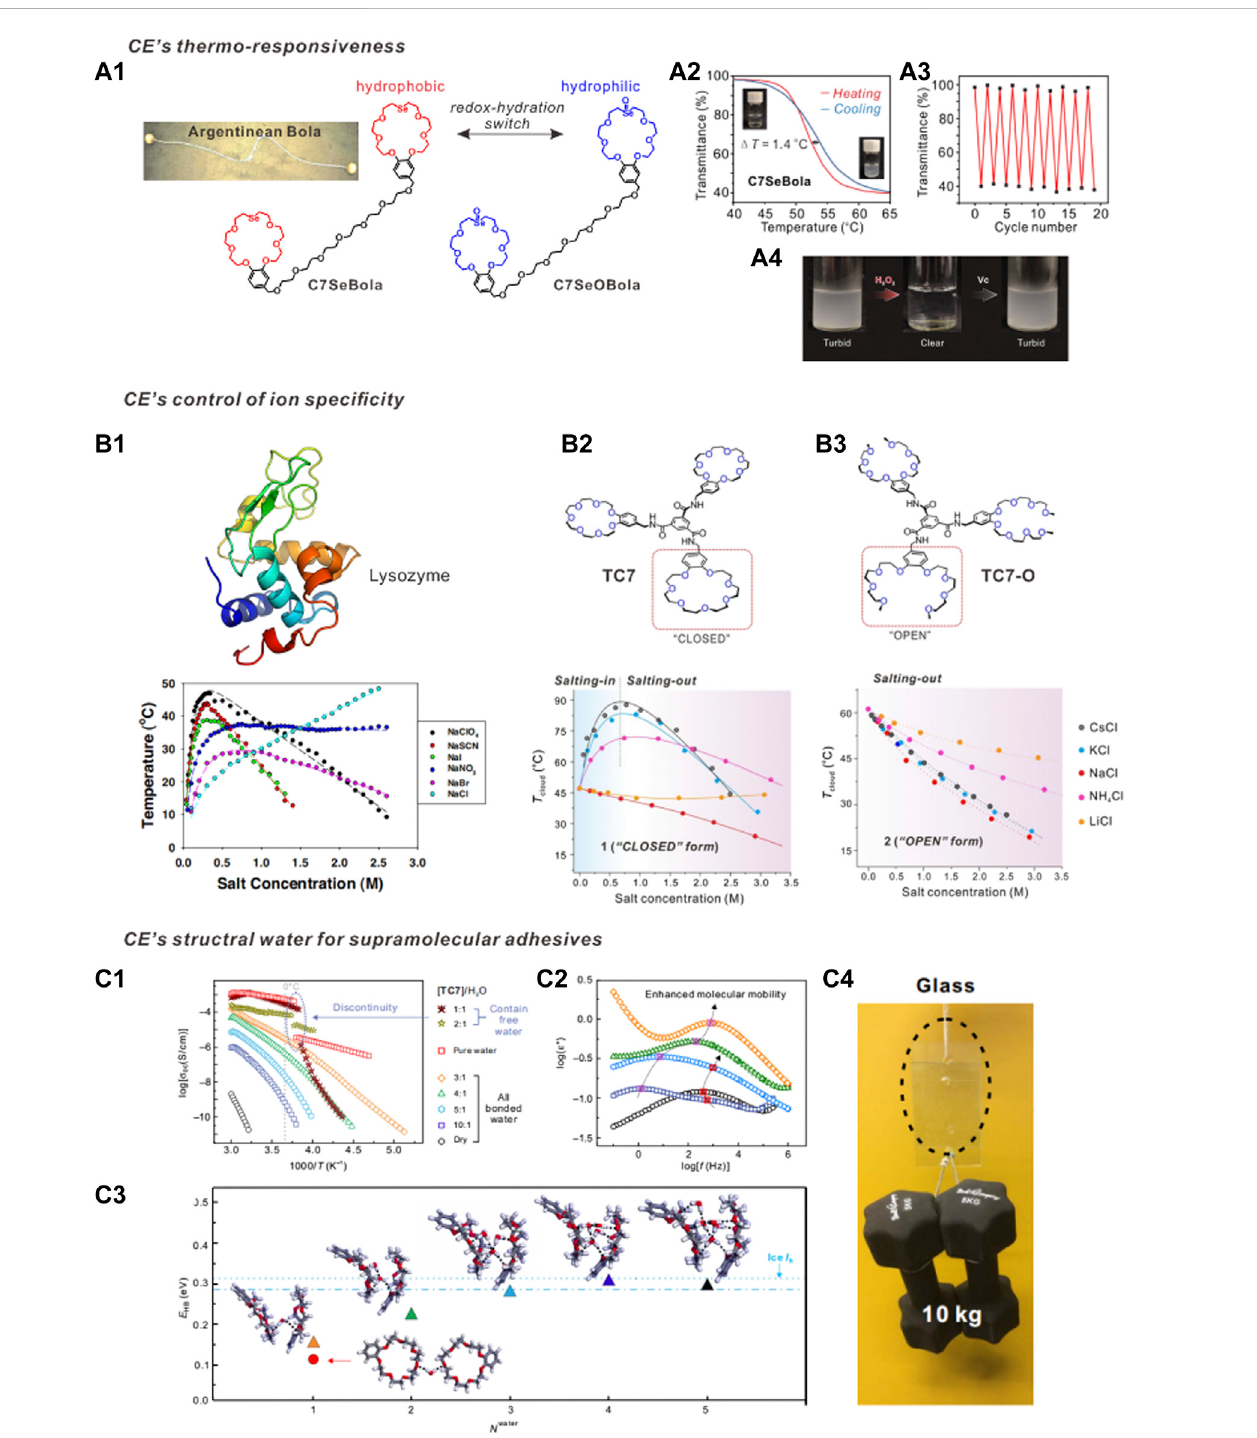
FIGURE 2 (A) The redox-controlled hydration of CE for design macrocyclic amphiphiles. (A1) the chemical structure of bolaamphiphile C7SeBola ; (A2) C7SeBola exhibited rapid LCST behavior in water, (A3) The highly reversible LCST transition processes, (A4) turbid-to-clear and clear-to-turbid transitions can be controlled in an “ ON-OFF ” manner. (B) Hofmeister series reversal behavior. (B1) Hofmeister series reversal of anions for lysozyme reported by Cremer et al. The apparent association constants of anionic-lysozyme interaction for ClO 4 − , SCN − , I − , NO 3 − , Br − and Cl − are 0.10, 0.10, 0.09, 0.10, 0.18 and 0.12 M − 1 , respectively. (B2) Hofmeister series reversal of cation for a triple-CE-molecule ( TC7 ). The inverse Hofmeister series at low salt concentration regimes should be the cation – solute interaction at wok. The charge density is initially dominant and then decays due to the increase of the ionic radius, then the enhanced “ size- fi tting ” induced molecular recognition dominants the system. (B3) Ring-open counterpart ( TC7-O ) showed no Hofmeister series reversal. (C) TC7 generatesstructuralwaterforfabricatingsupramolecularadhesivematerial. (C1) ThedependenceofDCconductivity σ dc versus1/Tfor TC7 n - H materialswith different water content. (C2) Dielectric loss versus frequency for TC7 n - H materials with different water content at a temperature of − 100 ° C; (C3) Averaged hydrogen-bond strengths (EHB) of CE-water systems with different number of water molecules ( N water ) as obtained from the density functional theory (DFT) calculations; (C4) Application of TC7 10 - H 1 materials as supramolecular adhesive materials. Adapted and reproduced from Xu et al. (2021), Qi et al. (2018), ZhangandCremer(2009),Dongetal.(2017b)withkindpermissionbytheElsevier,NationalAcademyofScience,Wiley-VCHandAmericanAssociationforthe Advancement of